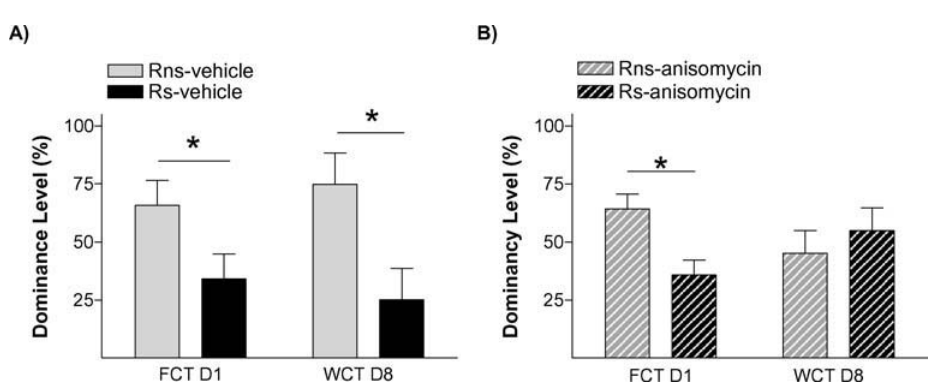
Figure 6. Social memory is dependent on protein synthesis. Graph shows dominancy level (%) during two competition encounters (FCT and WCT) of pairs rats treated with (A) vehicle (solid bars) or (B) anisomycin (hatched bars), immediately after FCT. No differences were found in WCT between Rns and Rs in pairs treated with anysomicin, suggesting that stress potentiates a hierarchy-linked recognition memory between specific individuals through mechanisms that involve de novo protein